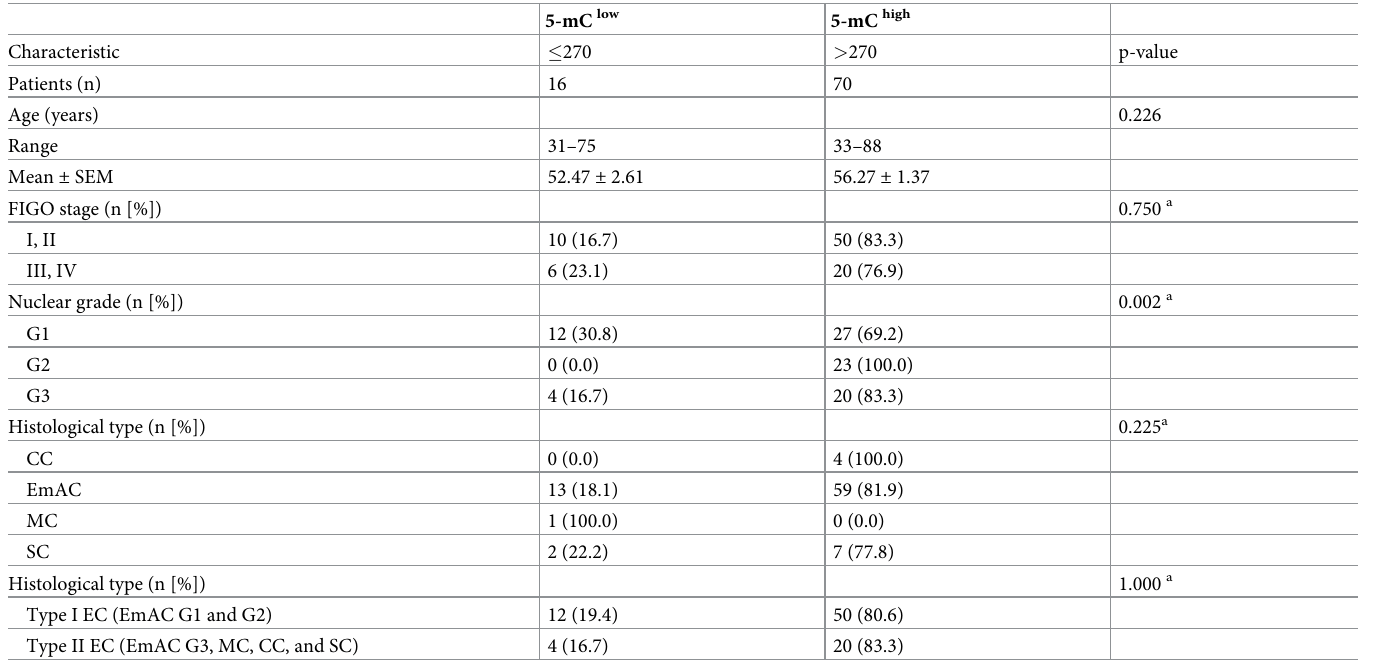
Table 5. Association of 5-mC expression score with clinicopathological features in EC.